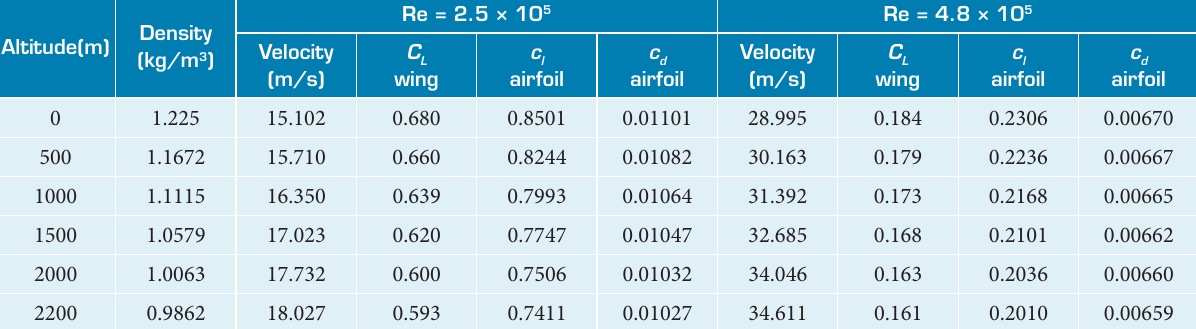
Table 6. Lift coefficients for selecting morphed airfoil and drag coefficients of selected morphed airfoil.